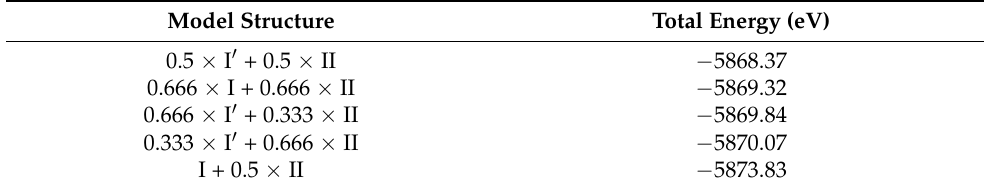
Molecules 2021 , 26 , x FOR PEER REVIEW 4 of 12 Table 1. Total energies calculated for the Na 32 -Y structure with various sodium spatial distributions. Model Structure